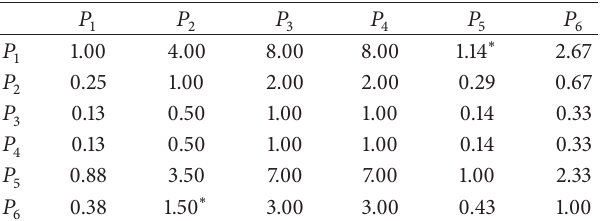
Table 13: Solution matrix of alternatives by the proposed approach (Example 3).